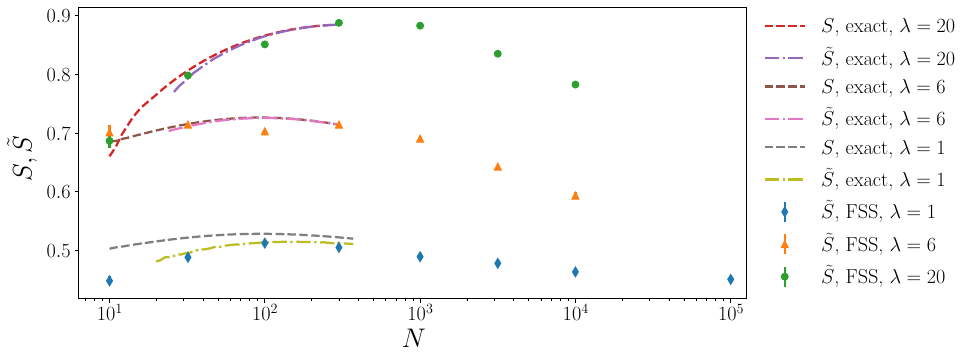
Figure 8: Ratio between microcanonical and the canonical fluctuations in a non- interacting harmonically trapped 3D gas. The coefficients S (the ratio of the peak fluctuations in both ensembles, see eq. 14) and ˜ S (see text) characterizing this ratio are shown as a function of the number of atoms N for different aspect ratios. Data points indicate solutions of the FSS method analysis. Solid lines represent exact results obtained using the recurrence relations given in Appendix